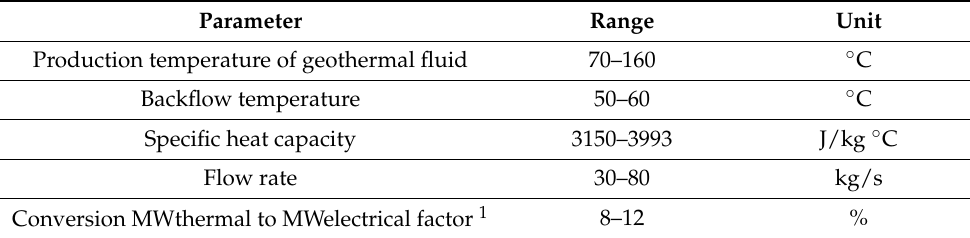
Figure 7. WCSB municipalities with >3 k population plotted against the maps of temperature at various geological surfaces [15]; ( a ) The base of Upper Devonian Beaverhill Lake Group; ( b ) The top of the Upper Devonian Winterburn Group; ( c ) The top of Mississippian formations; ( d ) at the sub-Mannville unconformity. Note: The red line depicts western margin of the undeformed WCSB. Table 2. Assumed